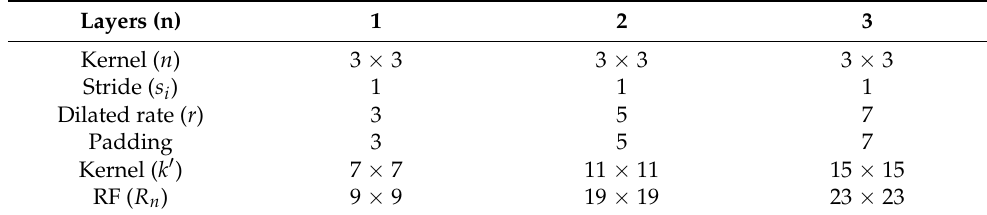
Table 1. Receptive field size with different dilated rates.